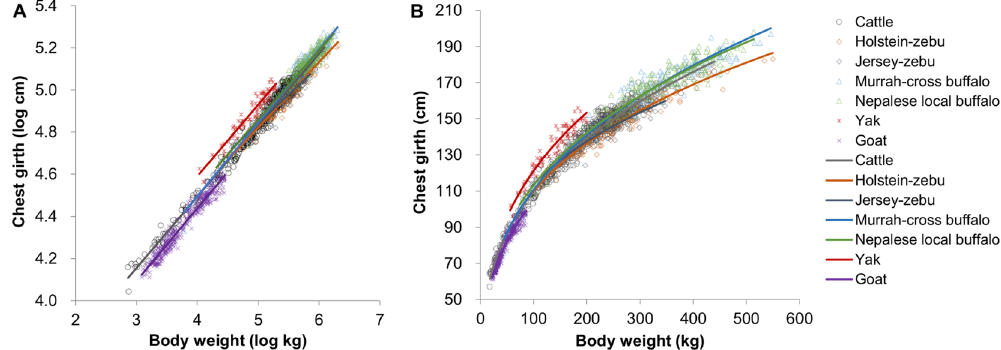
Figure 2. Estimated allometry with scatter plots of observations by species and breed. ( A ) Allometric lines on logarithmic scale. ( B ) Allometric curves on arithmetic scale.